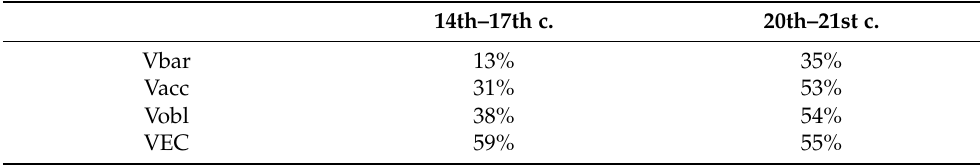
Table 5. Comparison of VX orders in two different